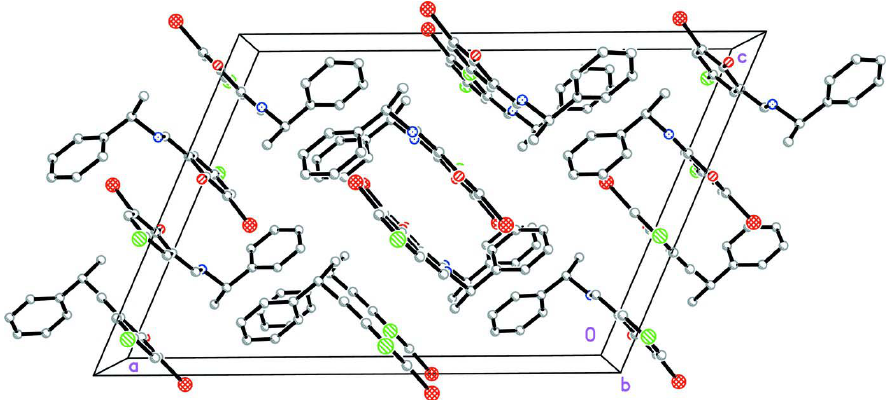
The structure of the title compound in 30% probability ellipsoids. H atoms are shown as spheres of arbitrary radii. The dotted line represent a hydrogen bond.